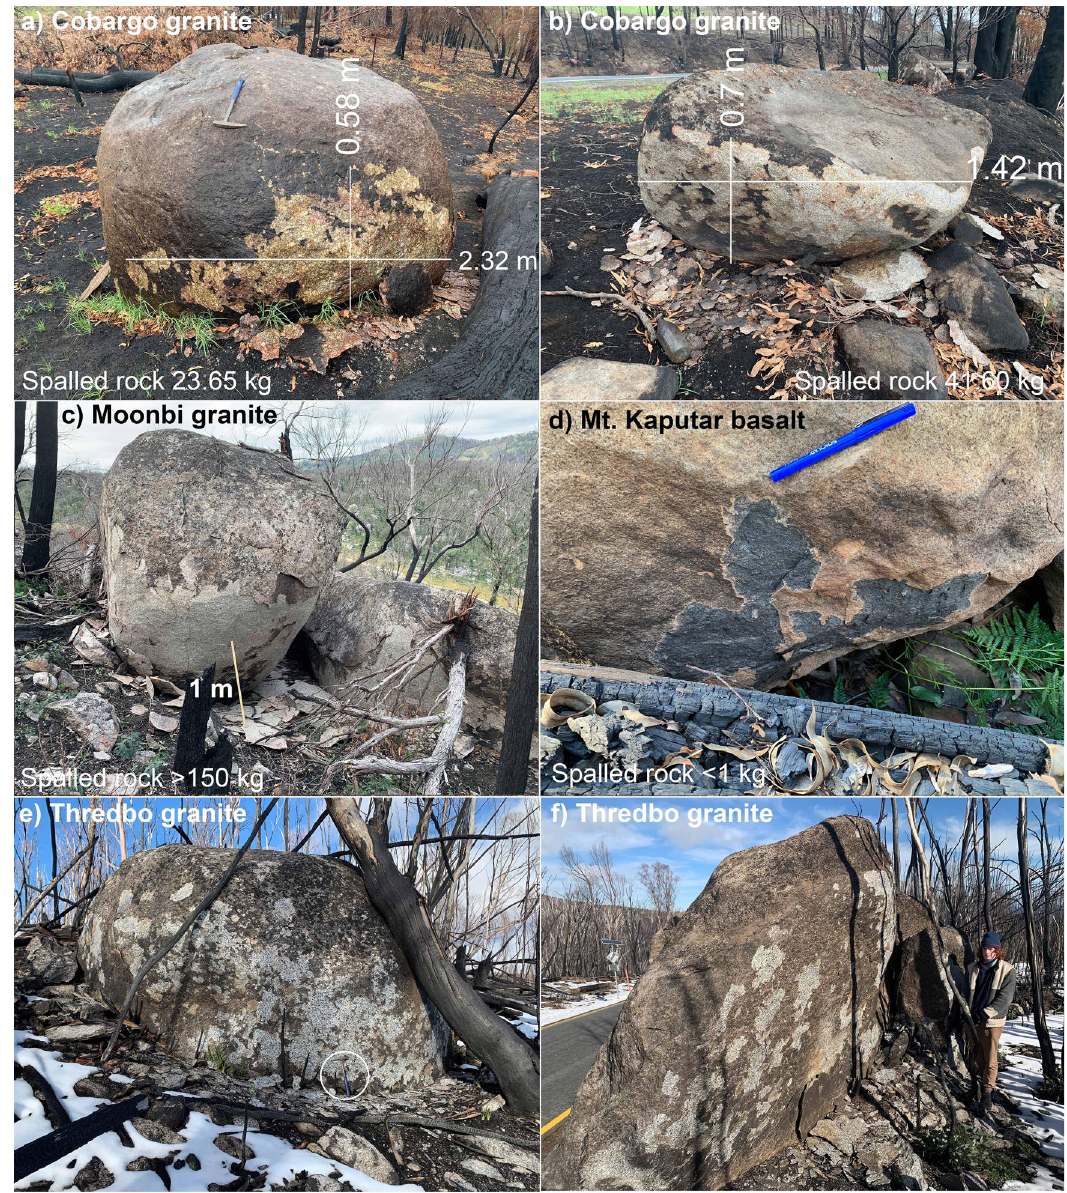
Fig. 4 Fire-related spalling on granite and basalt boulders of eastern Australia following the 2019 – 1020 fi res. a Granite tor near Quaama spalled 23.65kg of rock on the facing surface due to the intense and prolonged heat provided by the adjacent burnt log. Location − 36.509178, 149.831598. b Spalled granite boulder near Cobargo yielded 41.60kg of spalled rock of which 12kg was attributed to a single spalled slab visible on the lower right of the boulder. Location − 36.404498, 149.931435. c Intensely spalled Moonbi Granite near Tamworth, N.S.W., showing not one but several generations of spalled sheets fl aking off